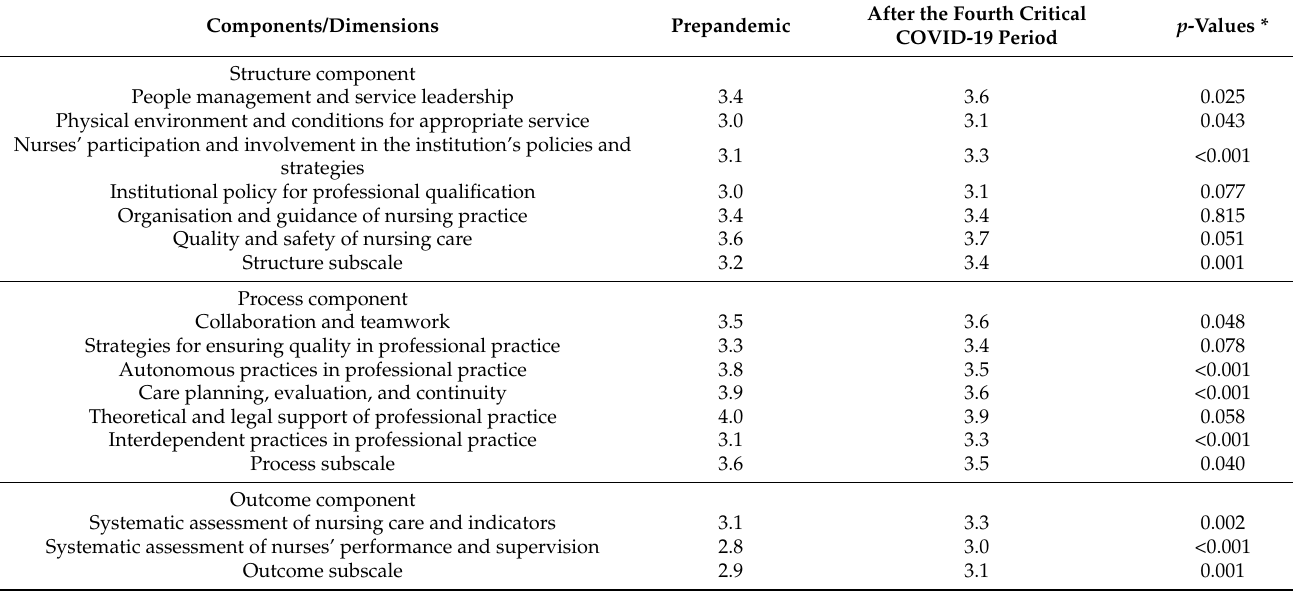
Table 1. Mean scores of the components/dimensions of nursing practice